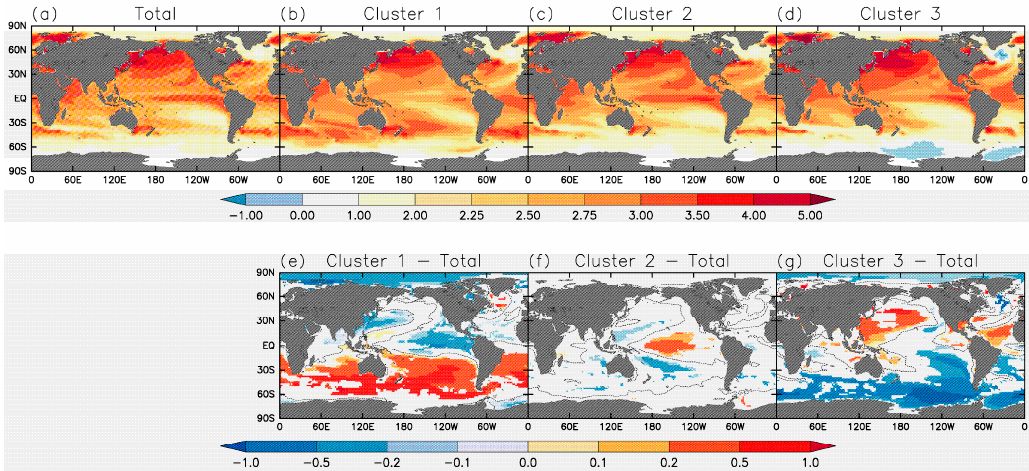
Figure 1. Annual mean sea surface temperature (SST) change (K) from the present-day (1979–2003, historical simulation) and the future (2075–2099, RCP8.5 scenario). ( a ) The composite of a total 28 models (C0); ( b ) the composite of the cluster C1; ( c ) C2; ( d ) C3; ( e – g ) differences for each cluster from the total mean (C0). The regions where over 75% of the models agree with the sign of the difference are colored. Contours denote zero. The change is normalized by the tropical (30° S–30° N) mean for each model before making the composition and then multiplied by the 28 models’ mean tropical SST change (2.74 K). From [31].